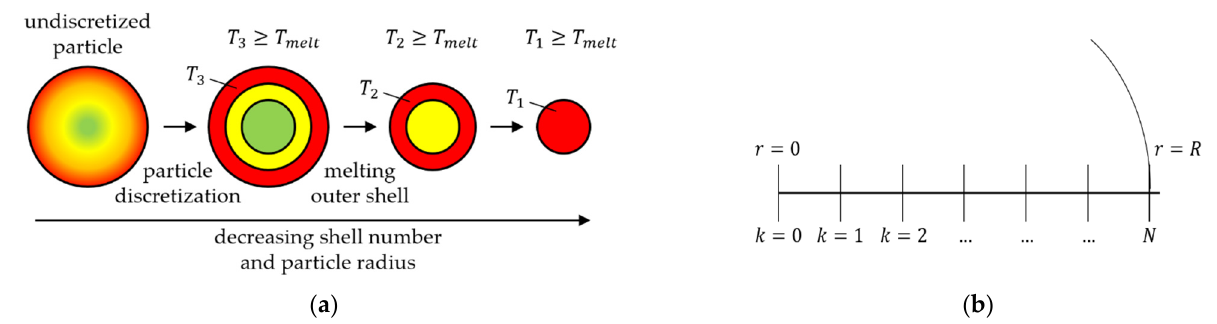
Figure 2. ( a ) Model presentation: heating of a spherical particle consisting of three shells; ( b ) discretization of a spherical particle with k = 0 to N shells over the entire particle radius R